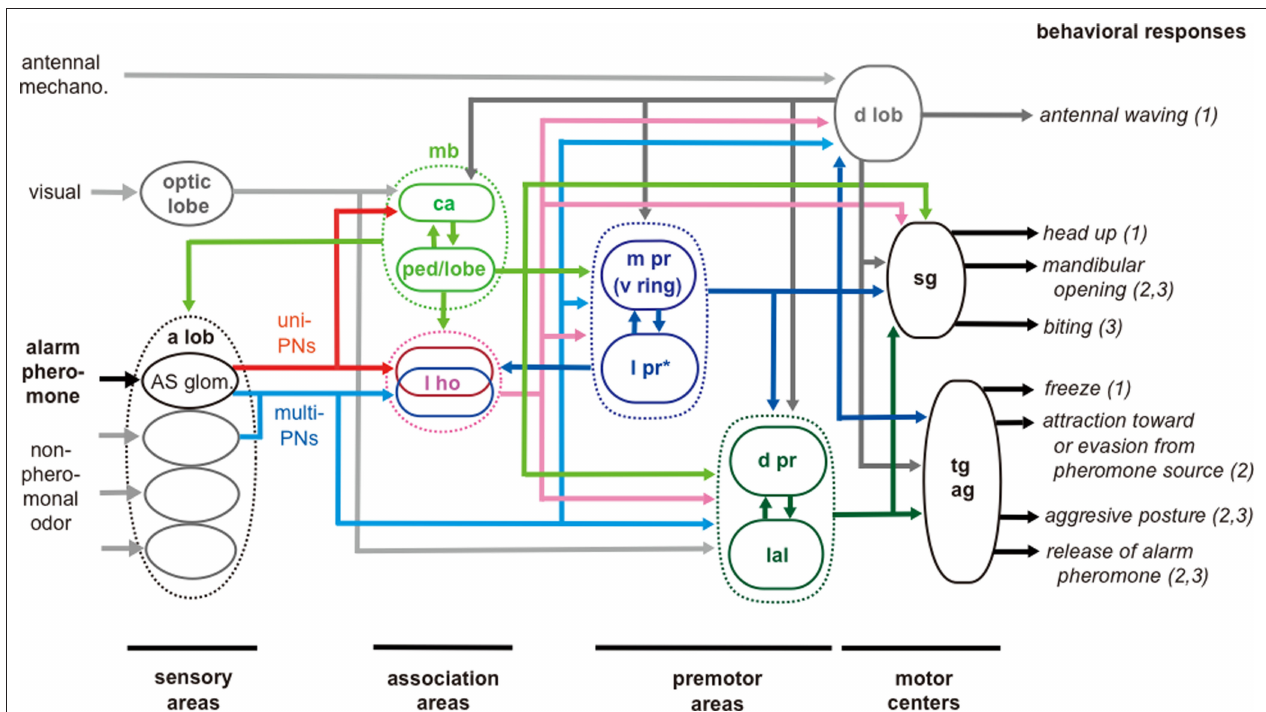
protocerebrum excluding the lateral horn. The distinction of sensory, association, premotor and motor areas is based on studies of basic organizations of the cockroach brain (Okada et al., 2003). To facilitate interpretation of data, we classified behavioral responses into (1) initial preparatory phase of alarm behavior, (2) alarm behavior and (3) aggression against a potential enemy, as reviewed by Blum (1985) and Vander Meer and Alonso (1998). Modified from Yamagata et al.